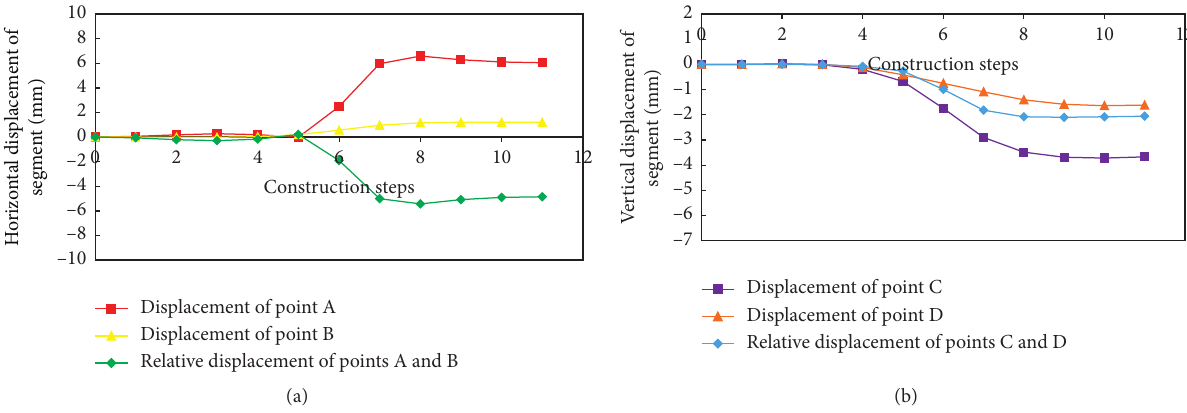
Figure 16: Displacement curve of 142nd ring segment in the construction processes of left tunnel excavation. (a) Horizontal displacement curves of points A and B. (b) Vertical displacement curve of points C and